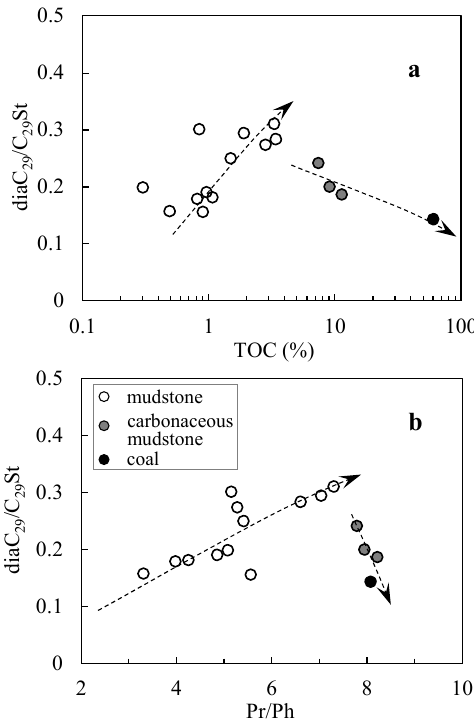
Figure 11. Cross-plots of C 29 diasteranes/C 29 regular steranes (diaC 29 /C 29 St) versus TOC ( a ) and Pr/Ph ( b ) for the studied source rocks.